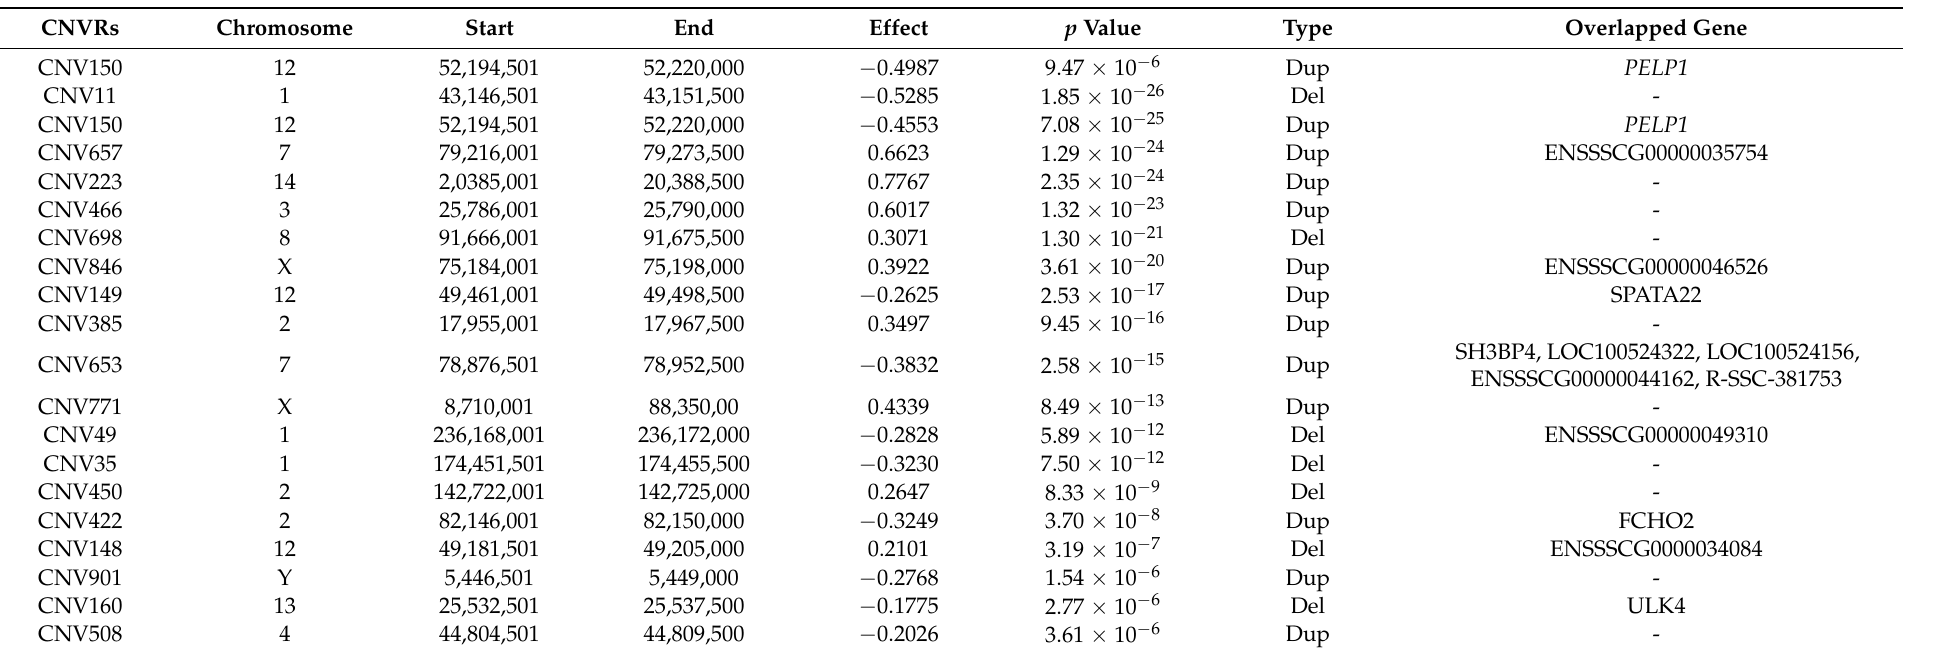
Table 1. Descriptions of the significant CNVRs associated with